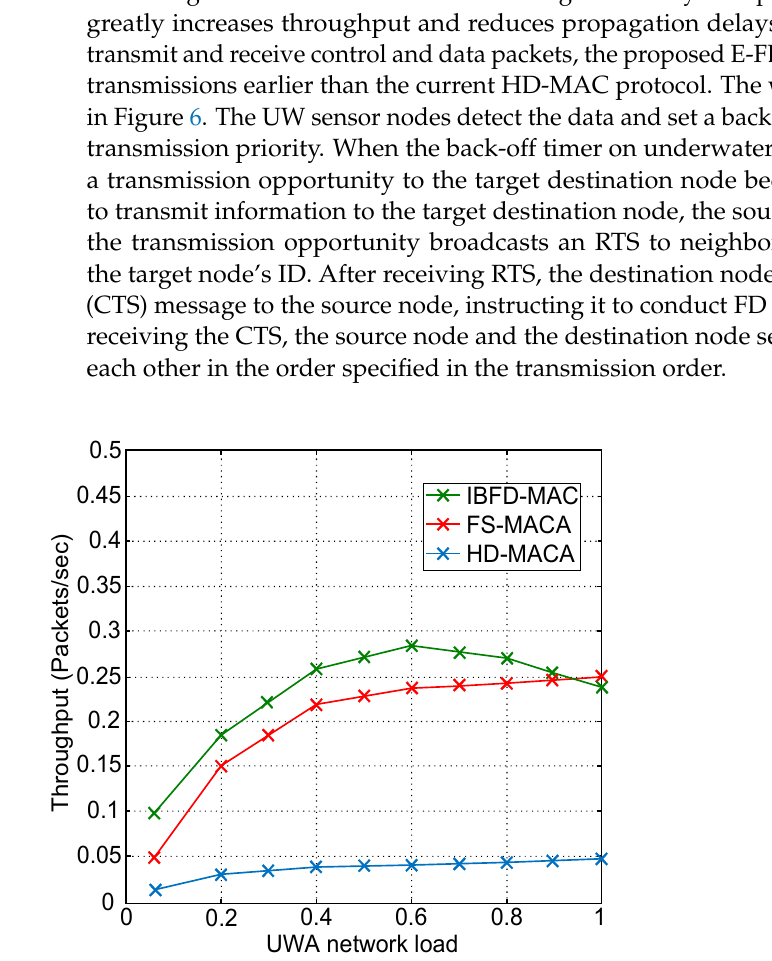
Figure 5. Throughput comparison of FS-MACA, HD-MACA and IBFD-MAC protocols.